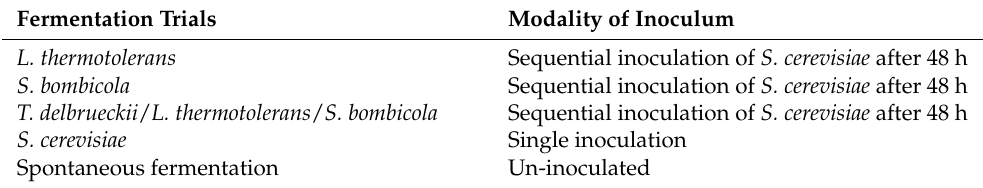
Table 1. The scheme of the fermentation trials of Verdicchio grape juice at vinery